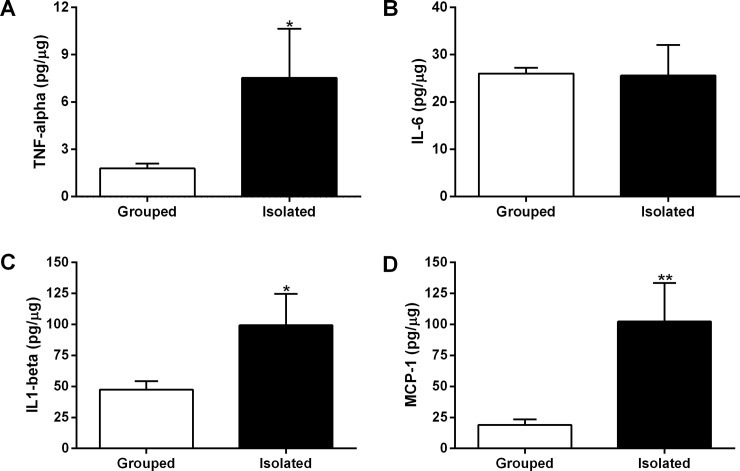
Levels of inflammatory mediators in the OSCC microenvironment.TNF-alpha (A), IL-6 (B), IL1-beta (C) and MCP-1 levels (D). Eight tumor samples from each group were randomly chosen to perform the analyzes. Student’s test T displayed that the levels of inflammatory mediators, except the IL-6 levels, were increased in the tumor microenvironment from isolated animals. *p<0.05 and **p<0.001 indicate a statistically significant difference. Bar graphs represent the mean ± standard error of the mean (SEM).